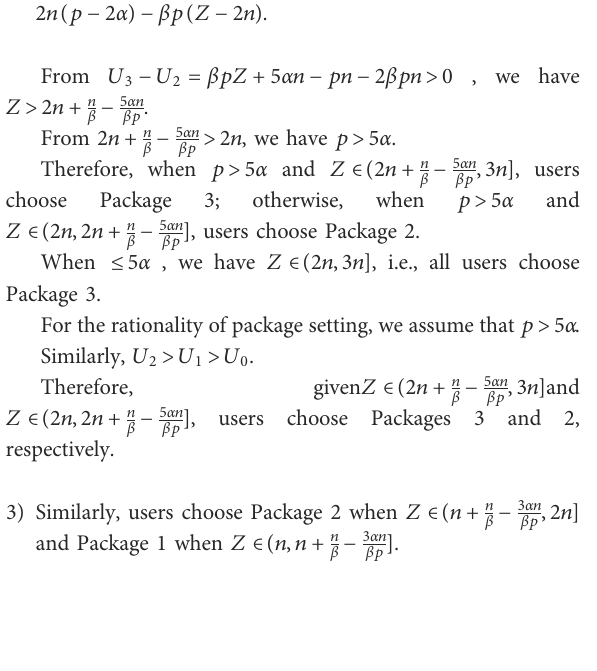
As shown in Figure 2, the average monthly electricity consumption of residents during peak and off-peak seasons and the upper limit of the monthly electricity consumption of residents are divided into regions to determine users who choose Package 2.